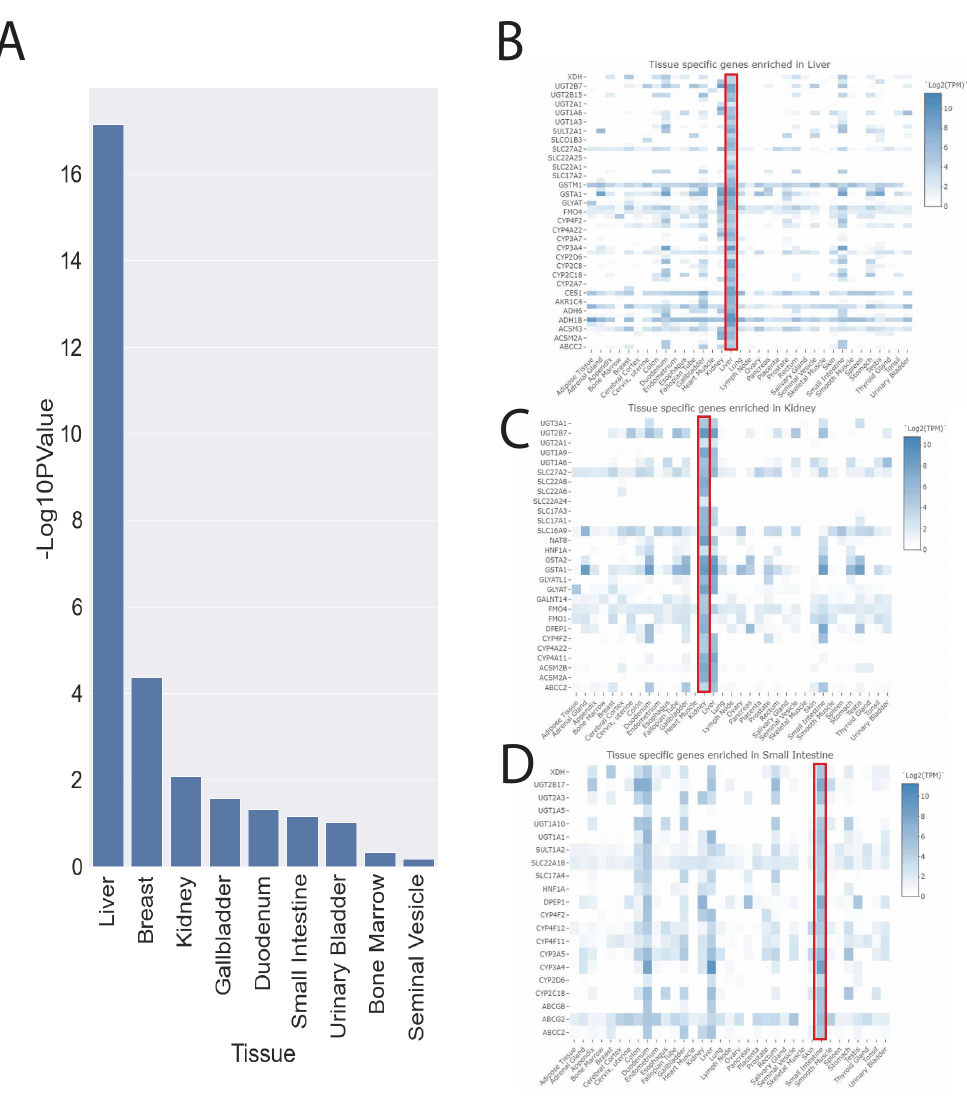
Figure 3. Tissue-specific enrichment reveals over-representation of organs active in ADME ( A ) The genes with significant associations with metabolites were compared to the reference genes listed in Supplementary Table S1. The liver, breast, kidney, gallbladder, duodenum, small intestine, urinary bladder, bone marrow, and seminal vesicle all had significant enrichment. ( B ) Genes enriched in the liver. ( C ) Genes enriched in the kidney. ( D ) Genes enriched in the small